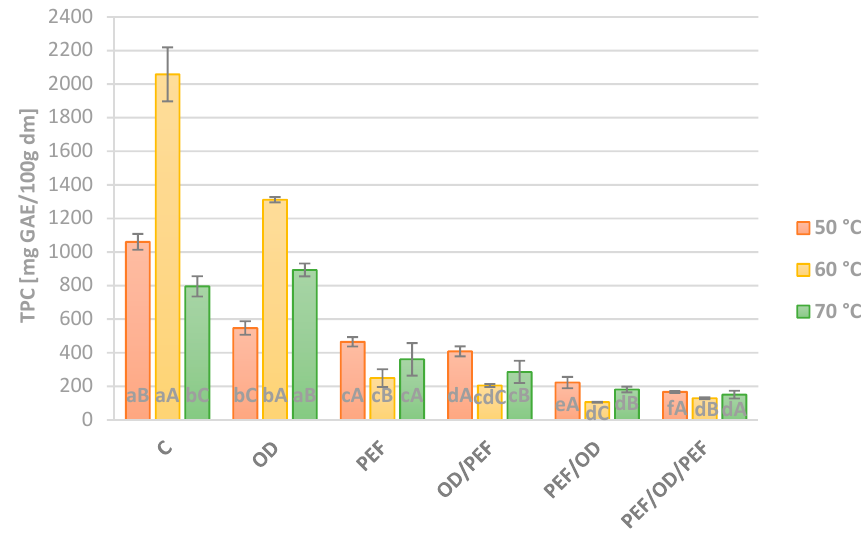
Figure 1. Total polyphenol content (TPC) of untreated and differently pre ‐ treated kiwifruit snacks dried at the temperatures of 50, 60 and 70 °C. Different lowercase letters indicate significant differences ( p < 0.05) between all considered samples at each drying temperature, while capital letters indicate significant differences ( p < 0.05) between each sample at the three drying temperatures.